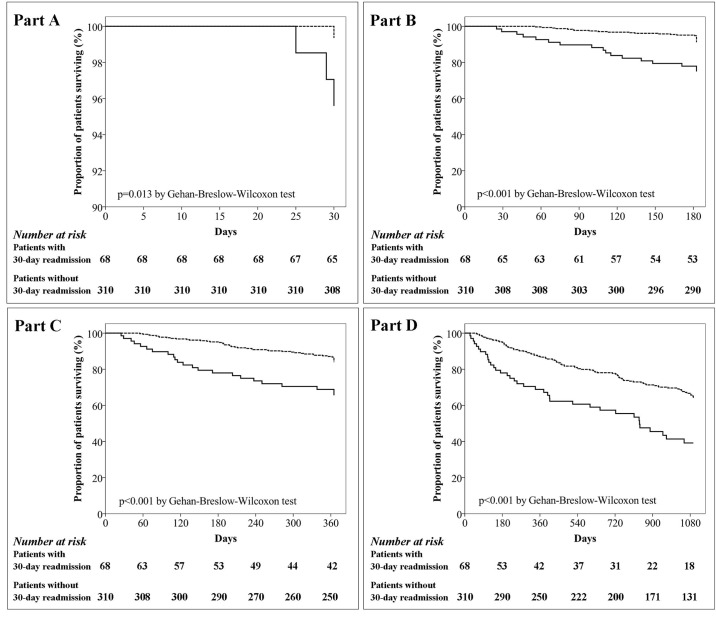
Kaplan-Meier survival curves in the follow-up period: at 30 days (part A), 6 months (part B), 1 year (part C), and 3 years (part D) from discharge after initial hospitalization.Continuous and dashed lines represent patients with and without 30-day readmission for AECOPD respectively.